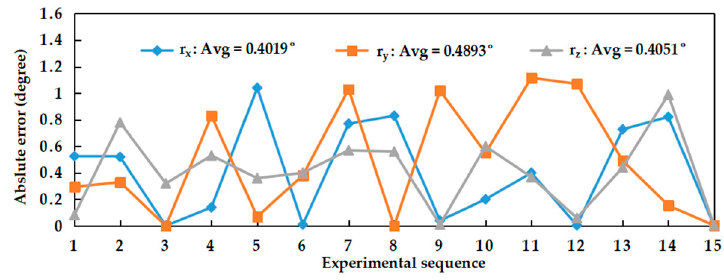
Figure 10. Absolute error of the Euler angles.